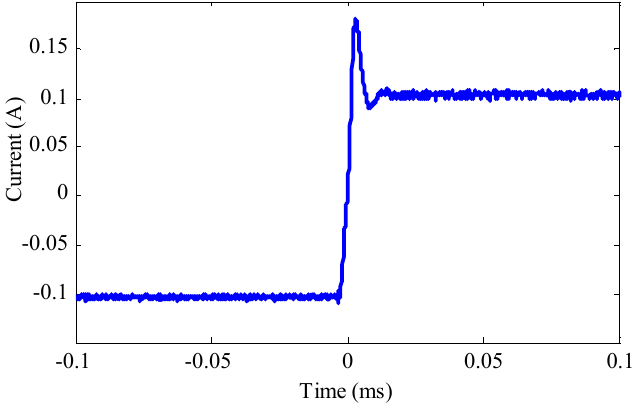
Figure 12. Step response curve of the amplifier.